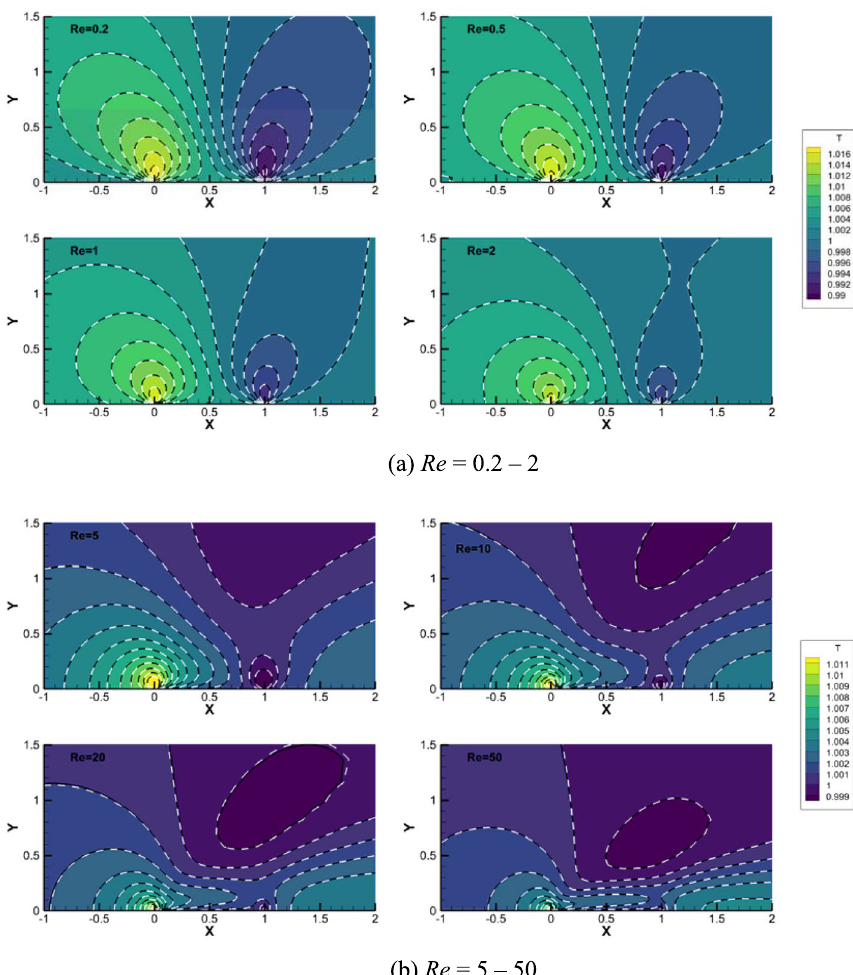
Fig. 6 Temperature contours around the flat plate in the ( a ) transition and ( b ) slip flow regimes (ADUGKS: colored background with black solid line; DUGKS: white dashed line)